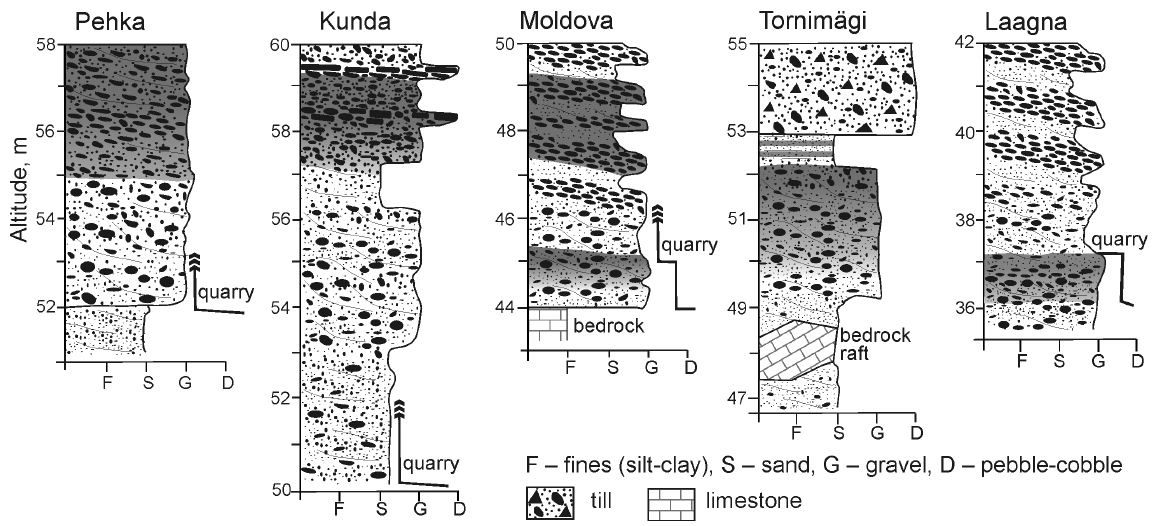
Fig. 4. Sedimentological profiles of the studied exposures. Cementation is marked in grey.